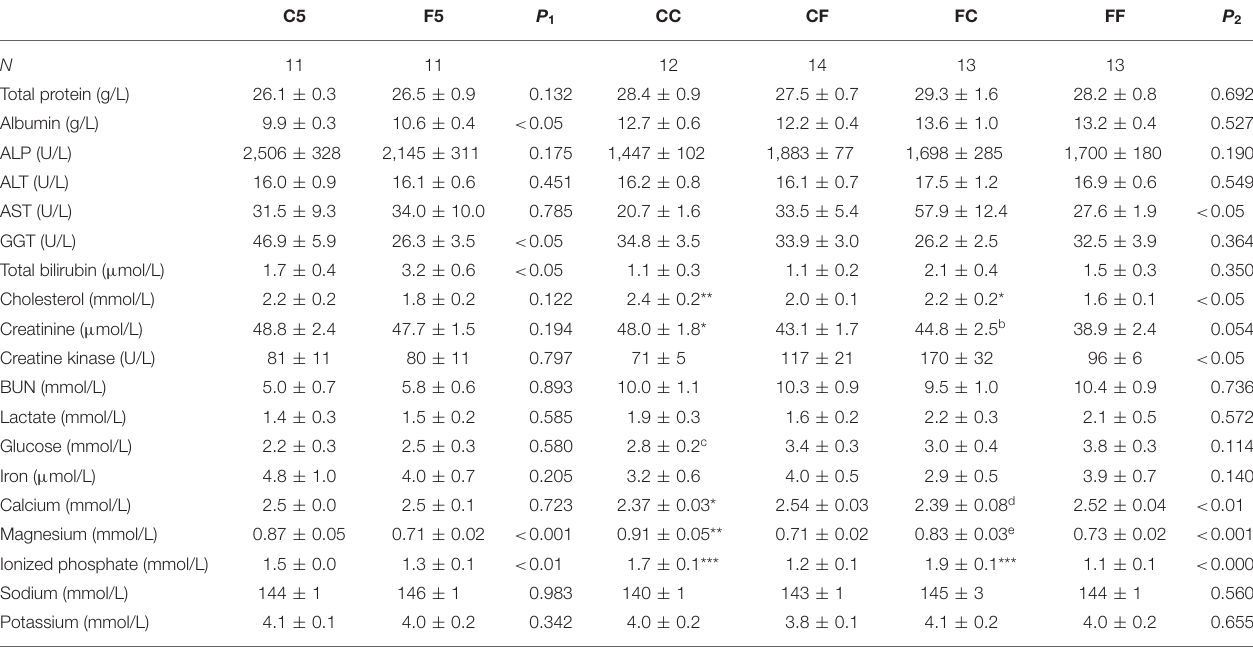
TABLE 4 | Blood biochemistry parameters a